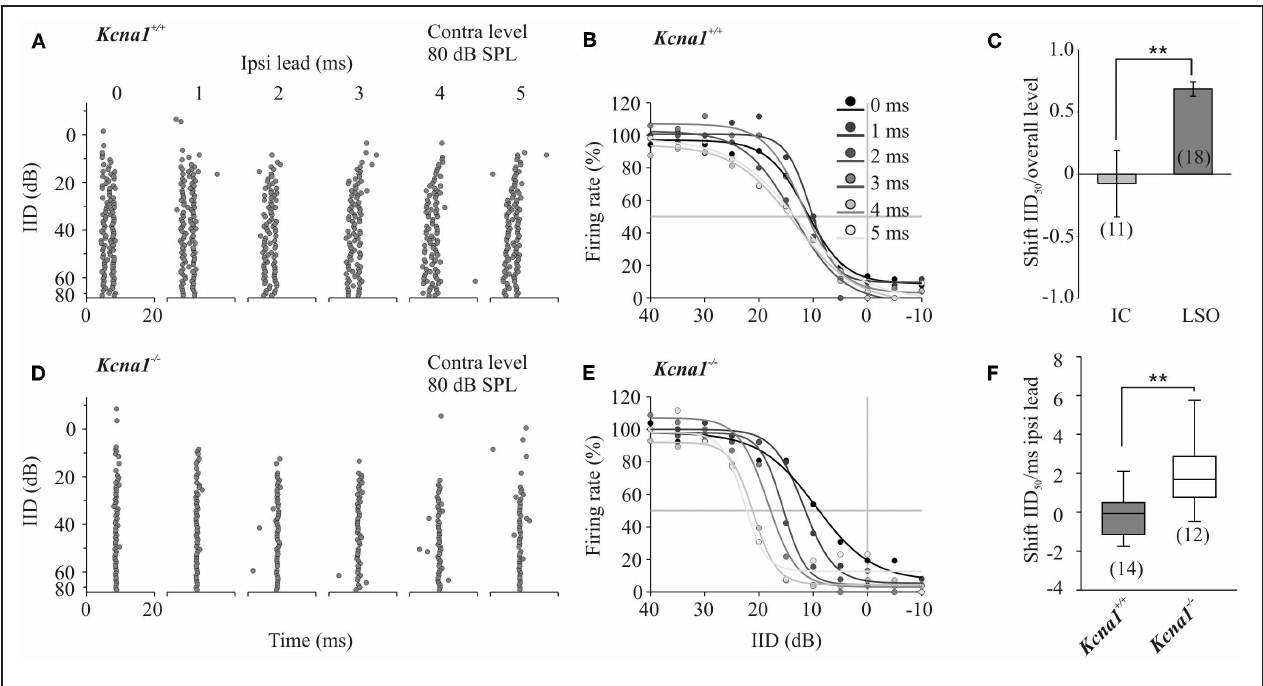
wild-type IC neurons was not only stable toward temporal mismatch in the inputs; they also showed a larger stability toward overall changes in sound intensity compared to wild-type LSO neurons. (D) Increasing the delay between excitatory and inhibitory inputs caused increasingly more effective inhibition in Kcna1 − / − neurons generating a remarkable shift of IID sensitivity toward more positive IIDs (E) . This shift in IID-functions with temporal lead of the inhibitory input is quantified in panel (F)